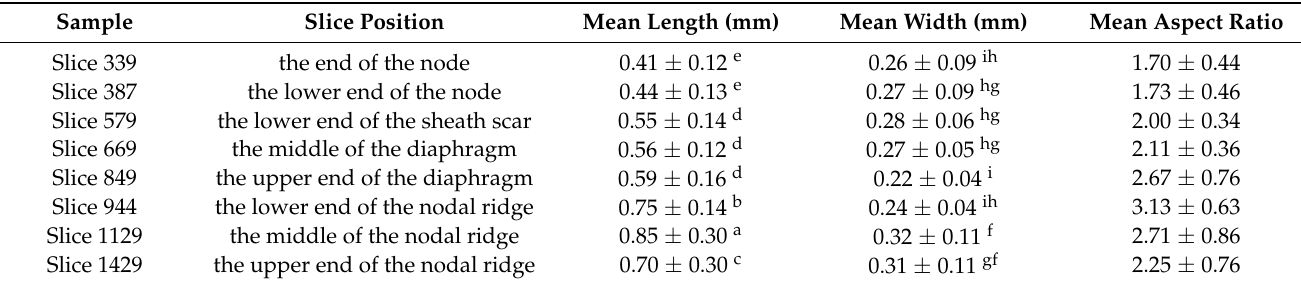
Table 1. The analysis of variance of the axial vascular bundles at different